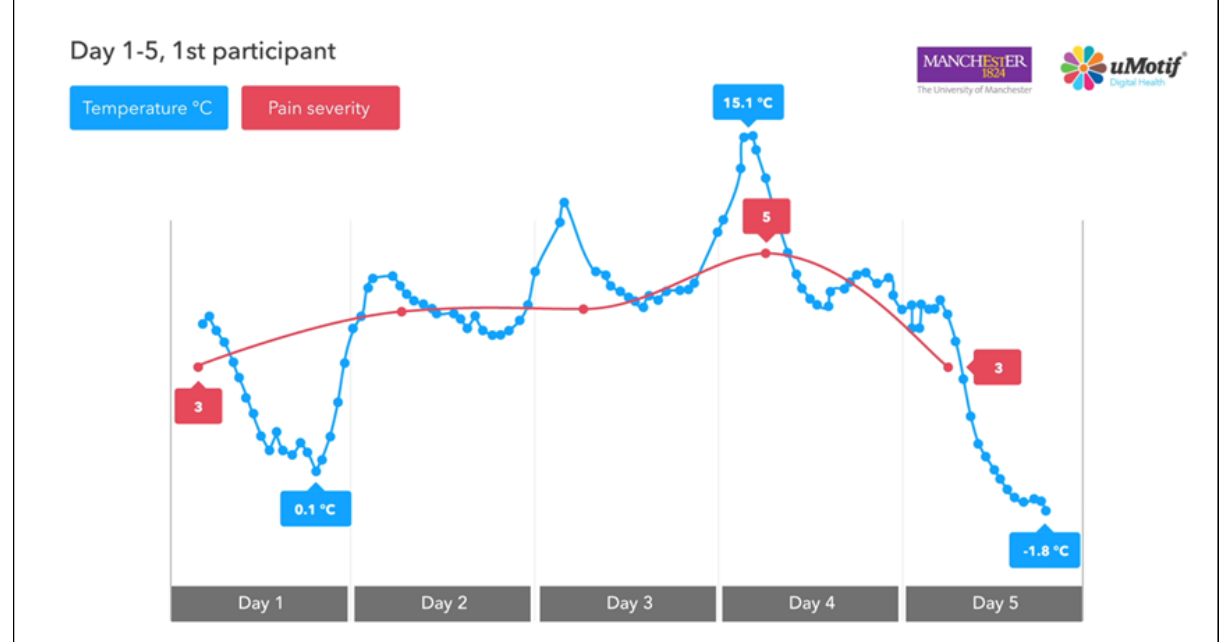
Figure 4. Example of self-reported symptom data and weather data from Global Positioning System–derived Met Office data (pain and